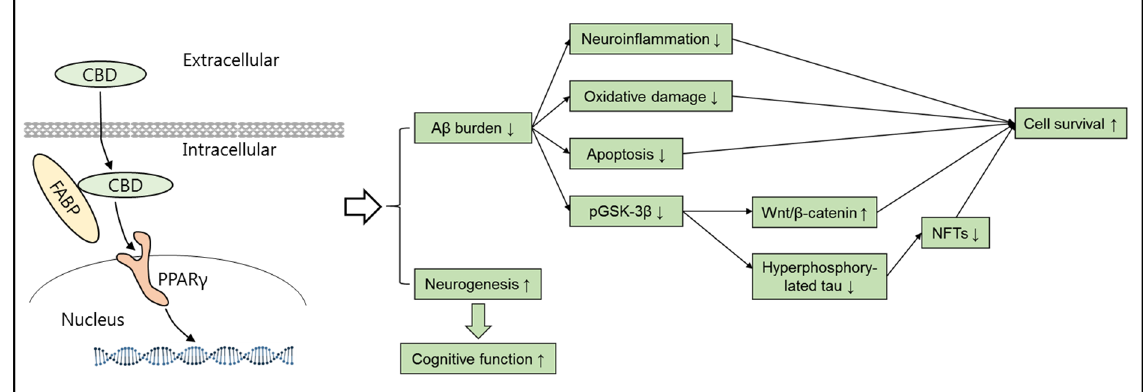
Figure 4. Summary of the main findings illustrating the neuroprotective functions of CBD against AD pathology. CBD can be translocated into the nucleus by FABPs and activate nuclear PPAR γ to induce gene expression, resulting in a series of improvements against A β -induced aberrant changes in AD, such as reduced neuroinflammation, oxidative changes, and apoptosis. In addition, CBD can contribute to the inhibition of hyperphosphorelated tau and activation of Wnt/ β -catenin signaling by recovering A β -induced pGSK-3 β . Finally, the CBD-mediated therapeutic changes facilitate neuronal survival. In addition, CBD enhances neurogenesis in AD. Overall, both CBD-mediated neuroprotection against A β -induced pathologies and CBD-mediated increase in neurogenesis might contribute to the improved cognitive function observed in AD.